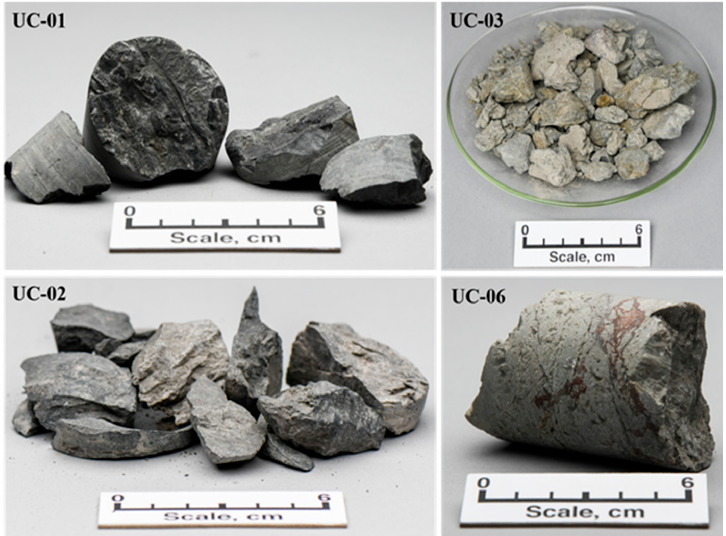
Figure 1. Photographs of as-received underclay core samples examined in this study. Information